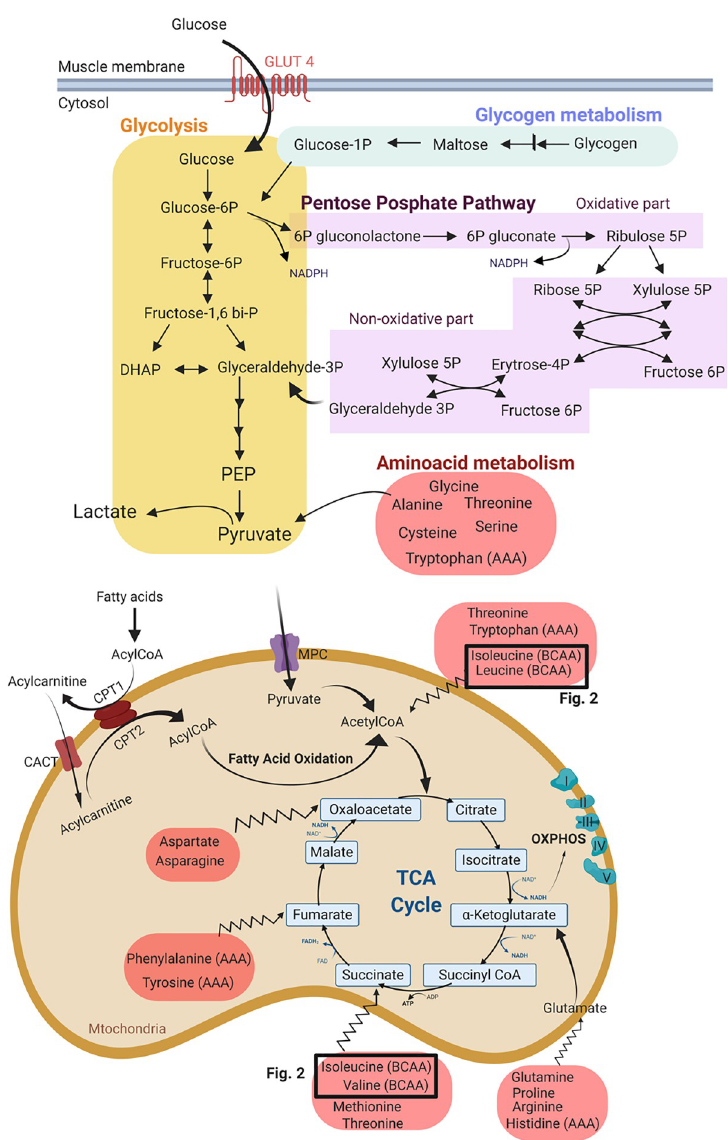
Fig 1. Metabolism in the cytosol and mitochondria of the skeletal muscle. The metabolites are grouped in different pathways: the glycogen metabolism pathway, glycolysis, pentose phosphate pathway (PPP) and amino